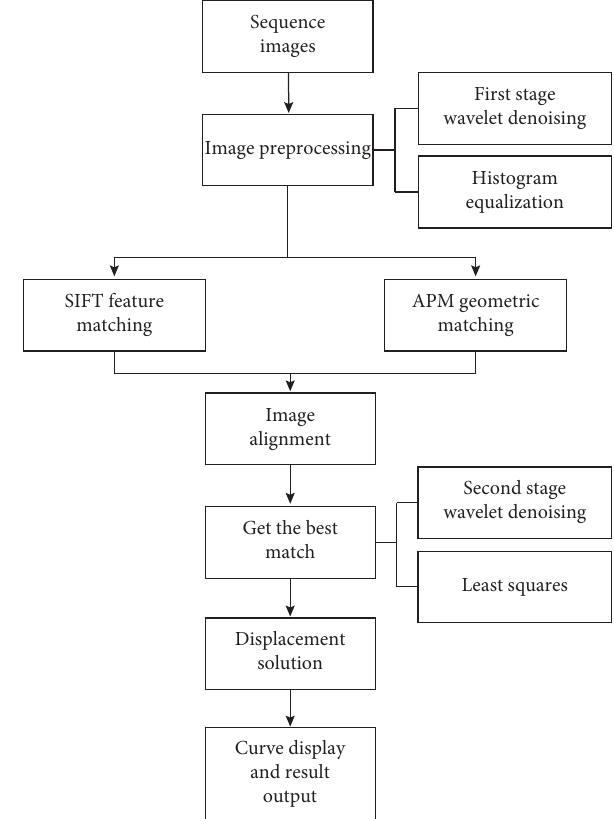
Figure 3: Method flowchart.